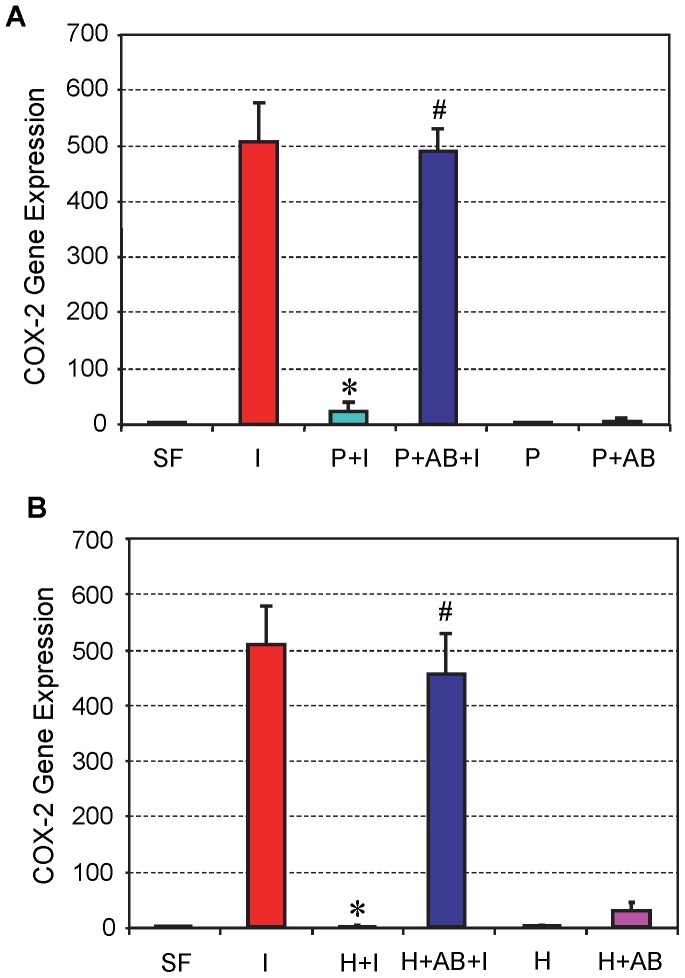
The effects of PRP (A) and HGF (B) treatment on COX-2 gene expression in tendon cell culture.Both PRP and HGF treatments nearly abolished COX-2 expression, which was induced by IL-1β treatment of tendon cells. Note that *P<0.05 is with respect to IL-1β treatment condition (I); and #P<0.05 is with respect to the PRP+IL-1β (P+I) group in A and the HGF+IL-1β (H+I) group in B. The data are expressed as mean ± SD, n  = 4. Label abbreviations and concentrations of all agents (IL-1β, PRP, HGF, and HGF antibody) are identical to legends in
Figure 2
. For SD values that are barely visible, the variation in gene expression values was less than 5 (control group, SF is 1).